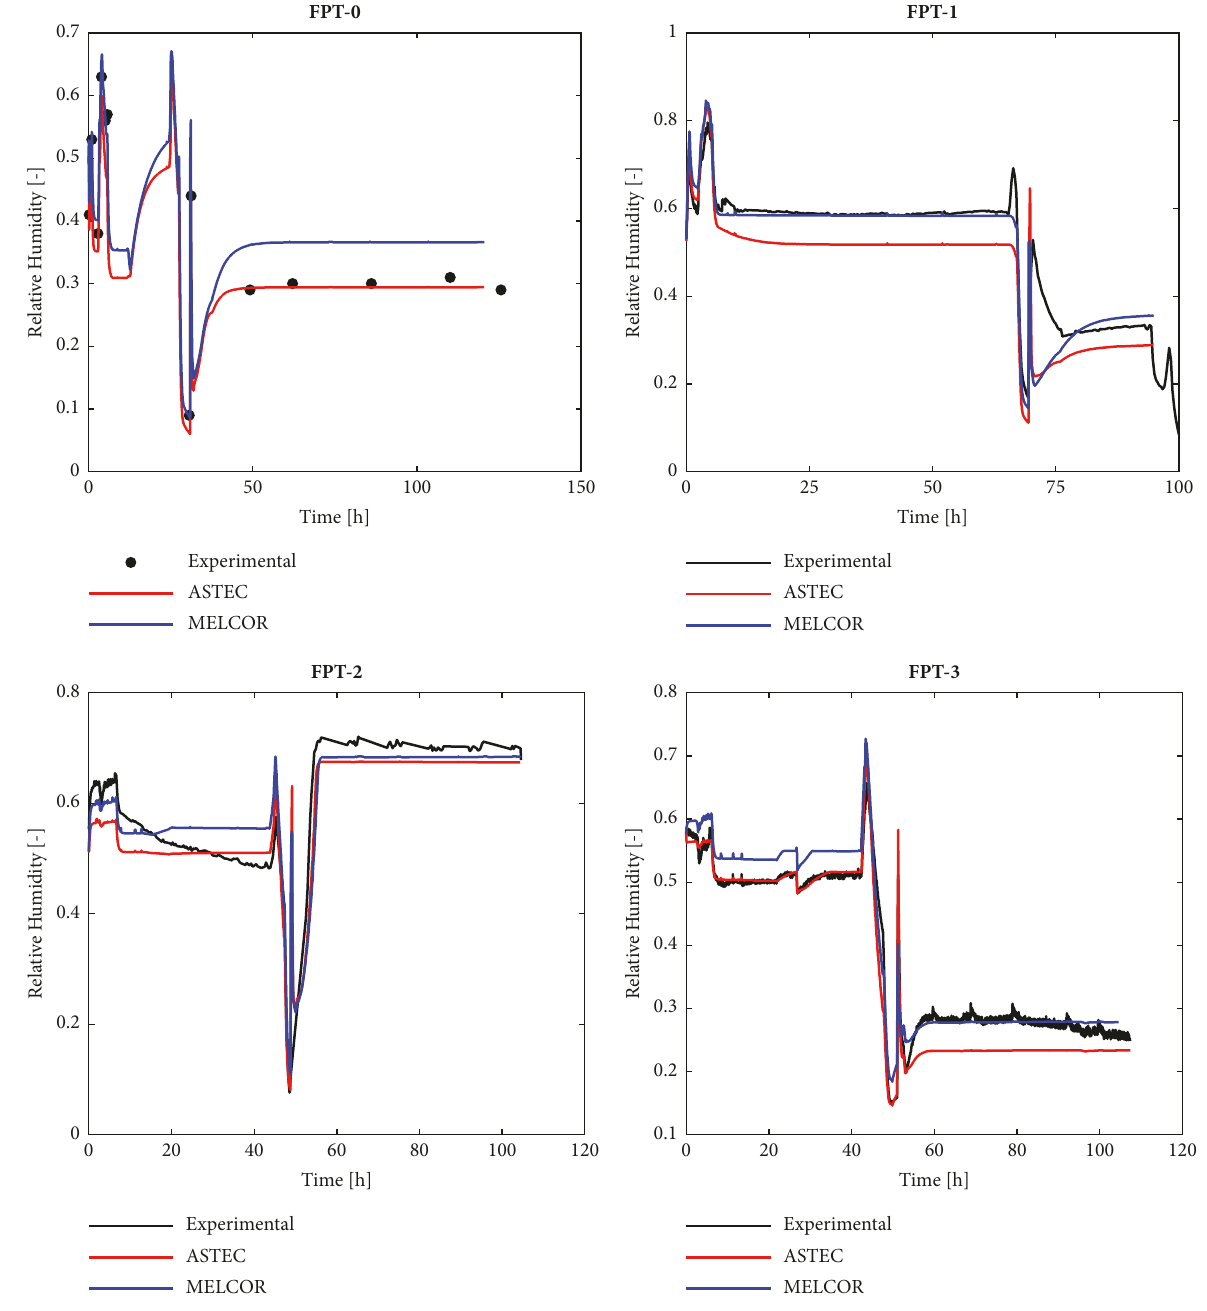
Figure 10: Relative humidity evolution during the Ph´ebus FPT